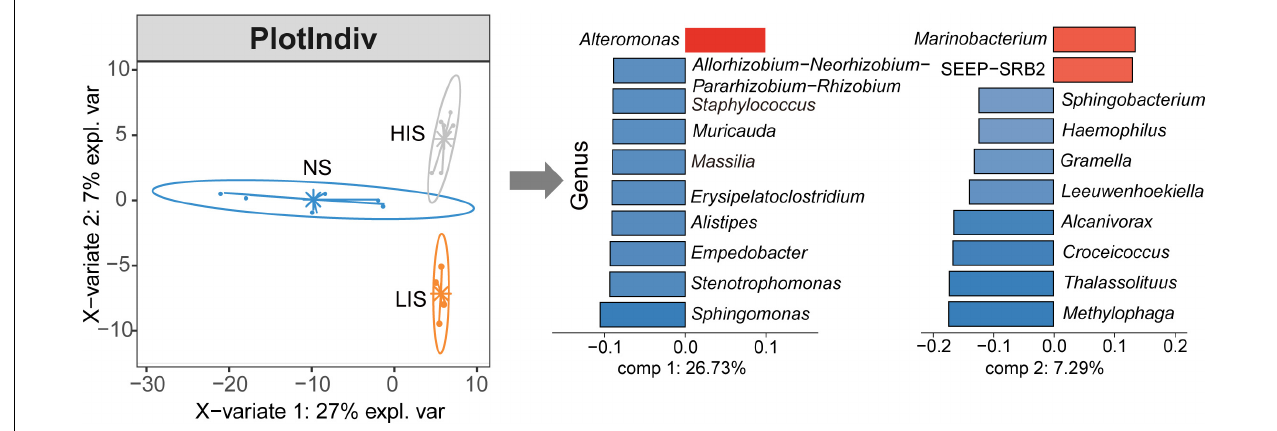
FIGURE 4 | Sparse partial least squares-discriminant analysis (sPLS-DA) of the three study sites. From component 1, genera labeled in red discriminate the LIS and HIS sites from the NS site and genera labeled in blue are characteristic genera at the NS site. From component 2, genera contributed to the dissimilarity between the LIS and HIS sites are labeled with blue and red, respectively.